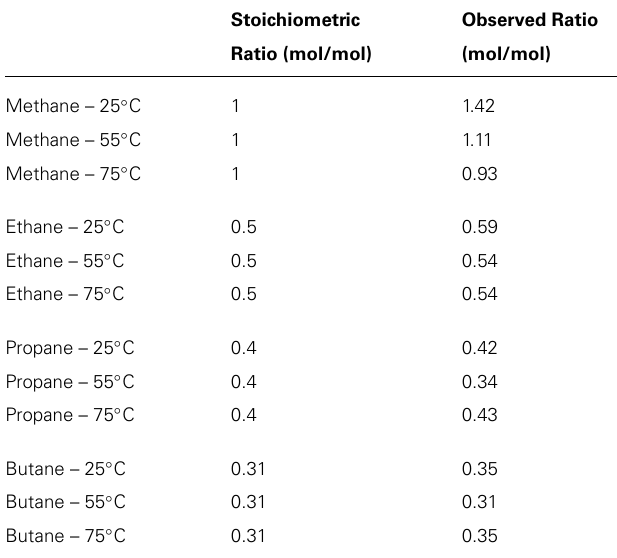
Table 2 |The predicted and calculated stoichiometric ratios for the anaerobic oxidation of methane, ethane, propane, and butane coupled to the reduction of sulfate to